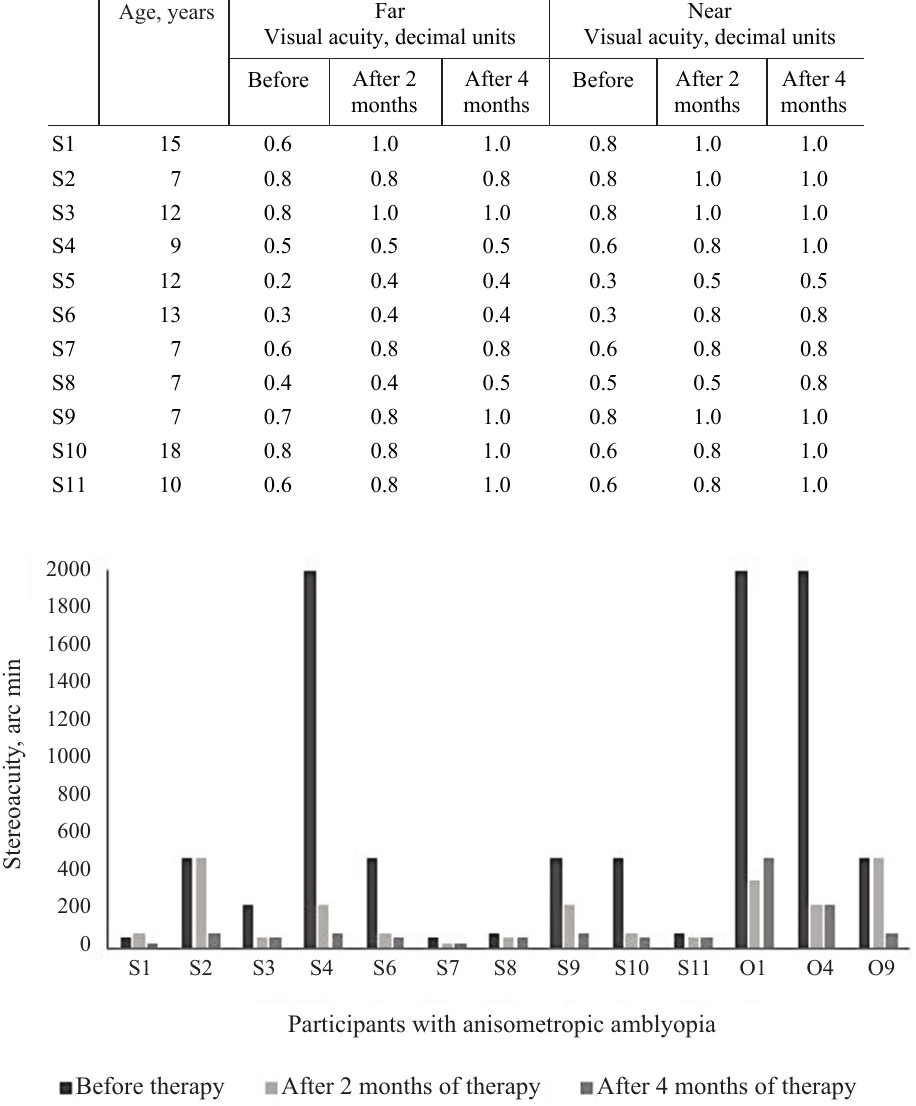
Fig. 3. Stereoacuity of participants with anisometropic amblyopia at near before, 2 months and 4 months after amblyopia